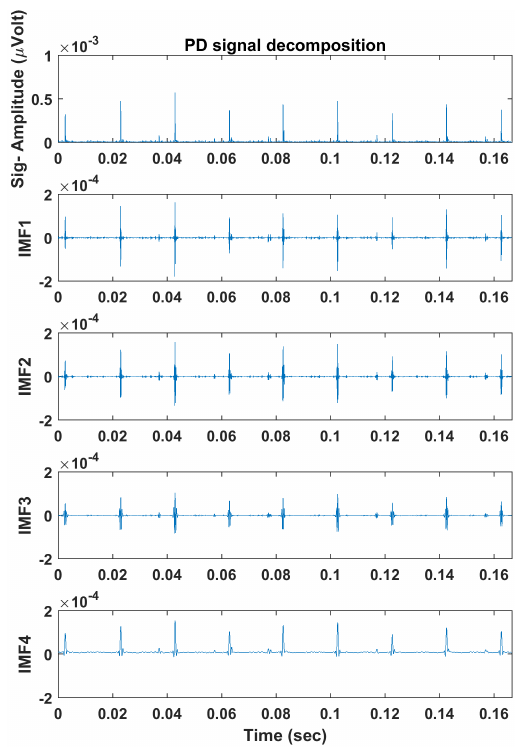
Figure 5. Example PD signal decomposed into Intrinsic Mode Functions (IMFs) using the Adaptive Local Iterative Filtering (ALIF) algorithm.